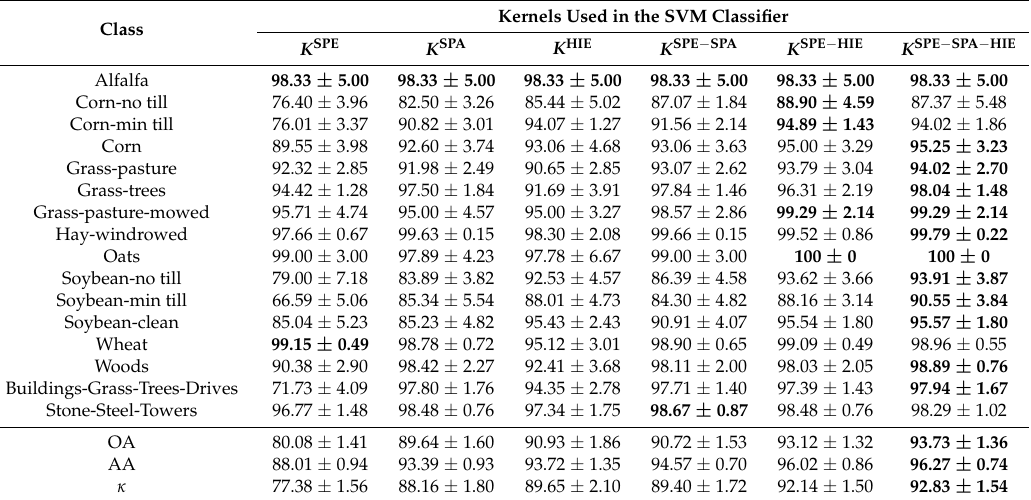
Table 2. Classification Results [Mean Accuracy (%) ± Standard Deviation] by the SVM Classifier with the Spectral, Spatial and Hierarchical Kernels for the IP Image. The best accuracies are indicated in bold in each raw.